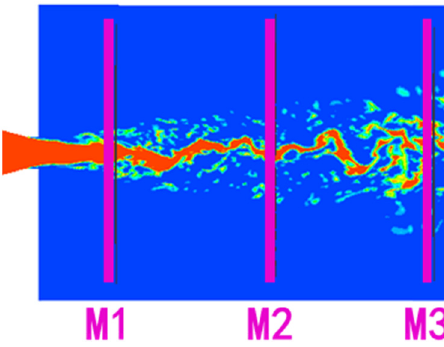
Figure 13: Positions M1 – M3 where droplet size distributions are calculated.